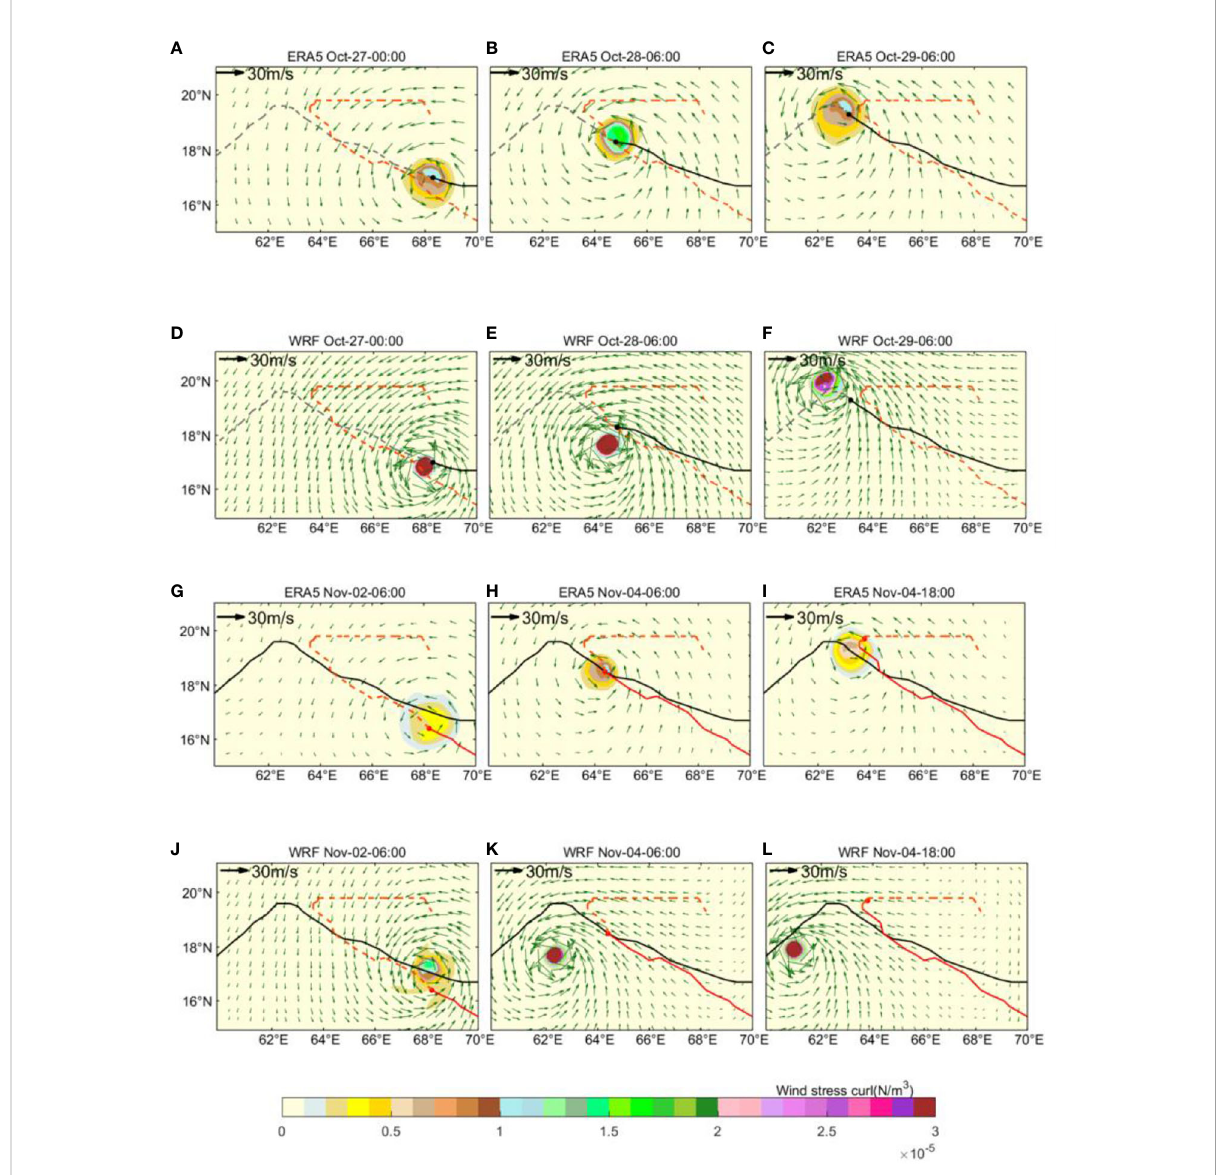
FIGURE 5 The hourly wind fi eld (arrows: m/s) at 10 m above the sea surface and estimated wind stress curls (colours: N/m 3 ) during (A – F) Kyarr ’ s passage and (G – L) Maha ’ s passage from ERA5 data and WRF model simulation, respectively. The expression of the TC tracks is the same as that in Figure